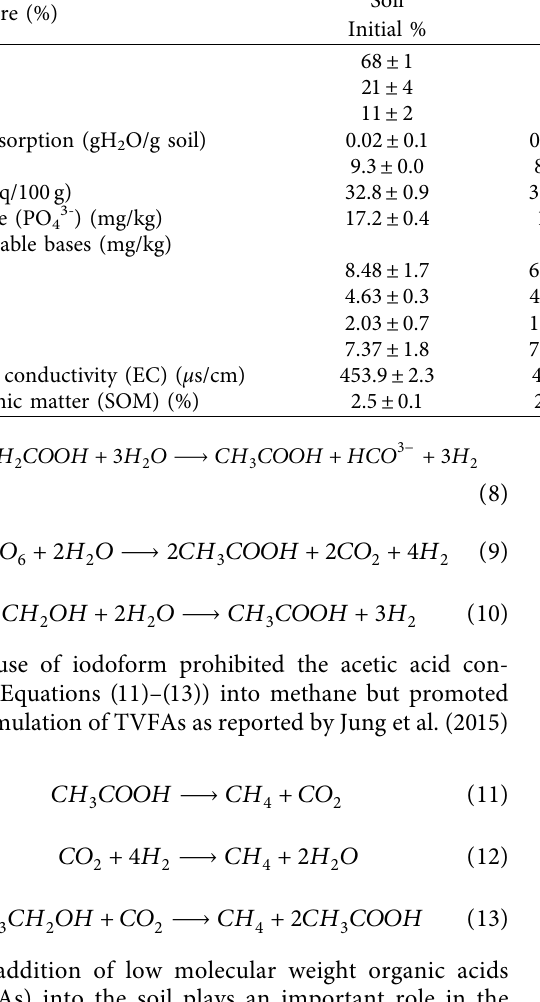
Table 2: The influence of fermented seaweed (FSW) amendment on selected soil properties at the end of the experimental phase (120th day). Soil texture (%)